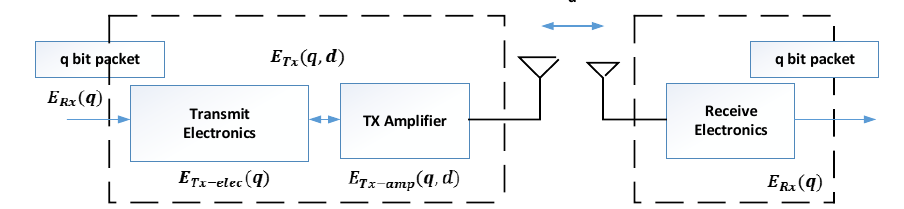
Figure 1. Radio energy